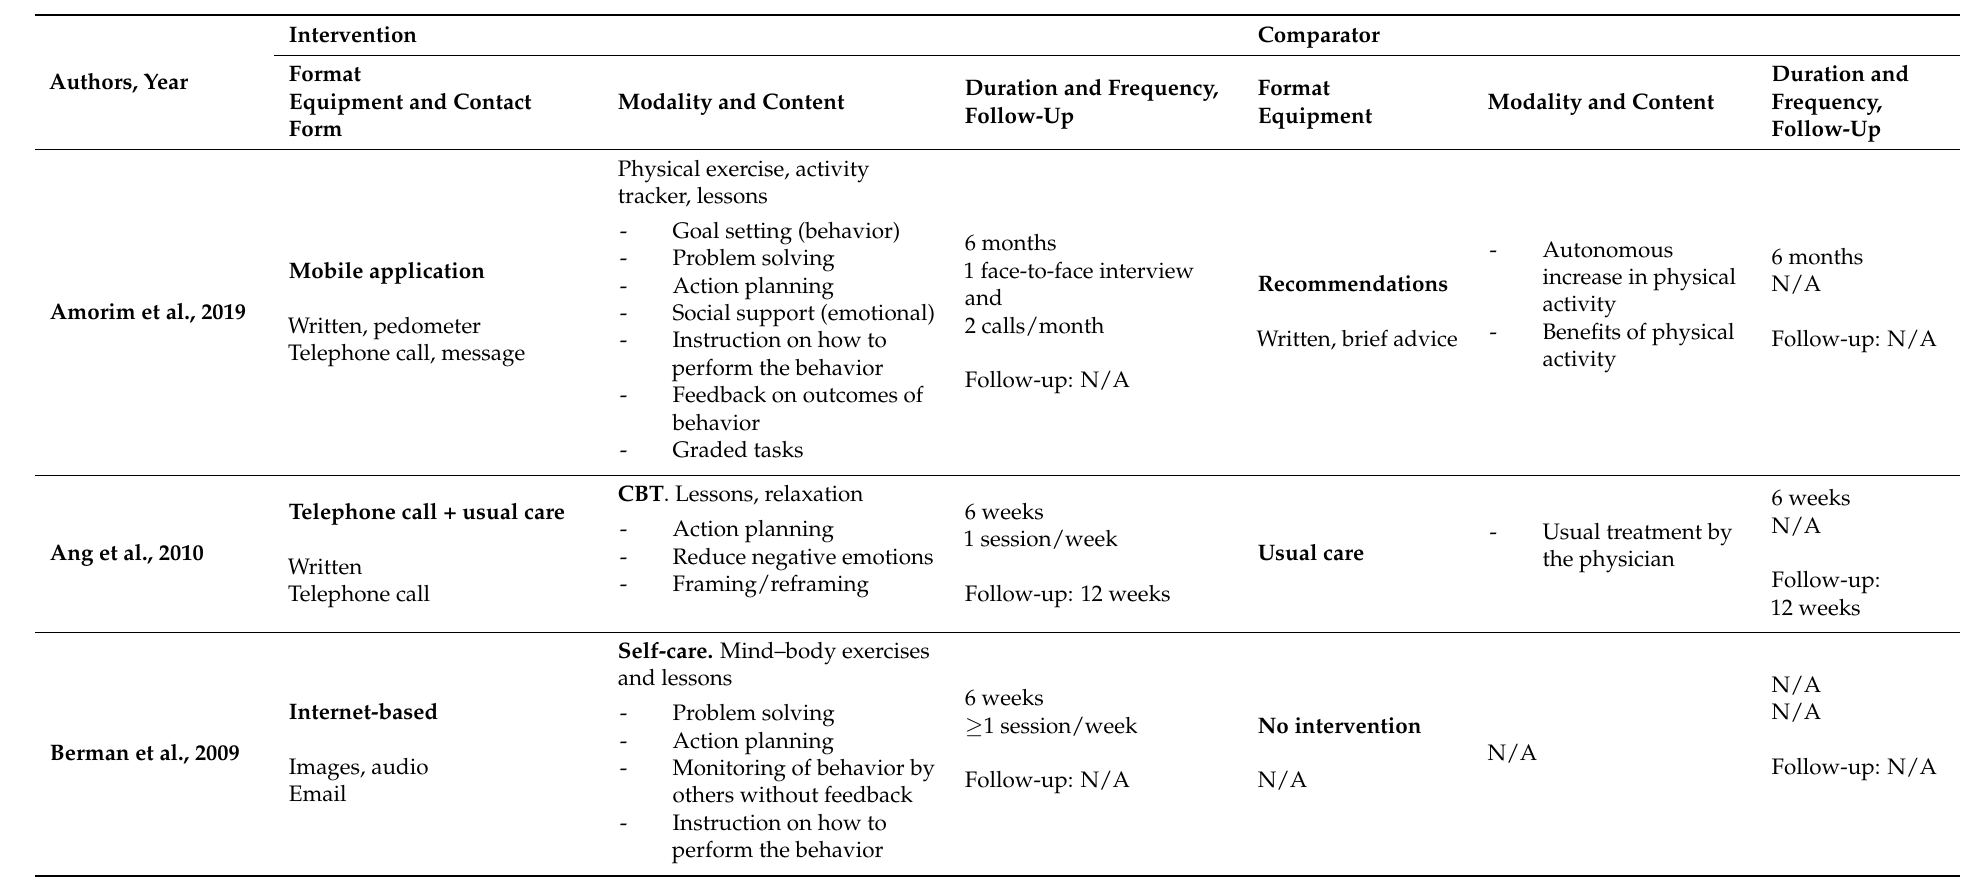
Table A2. Details of the